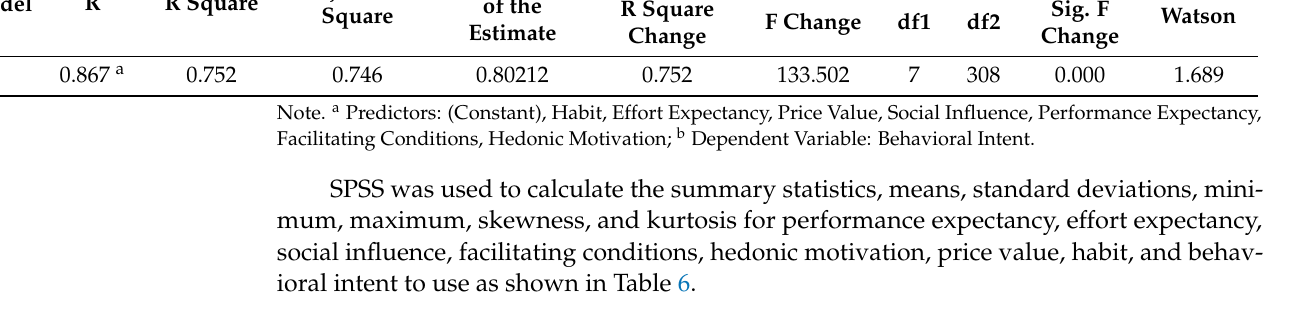
Table 6. Summary statistics.